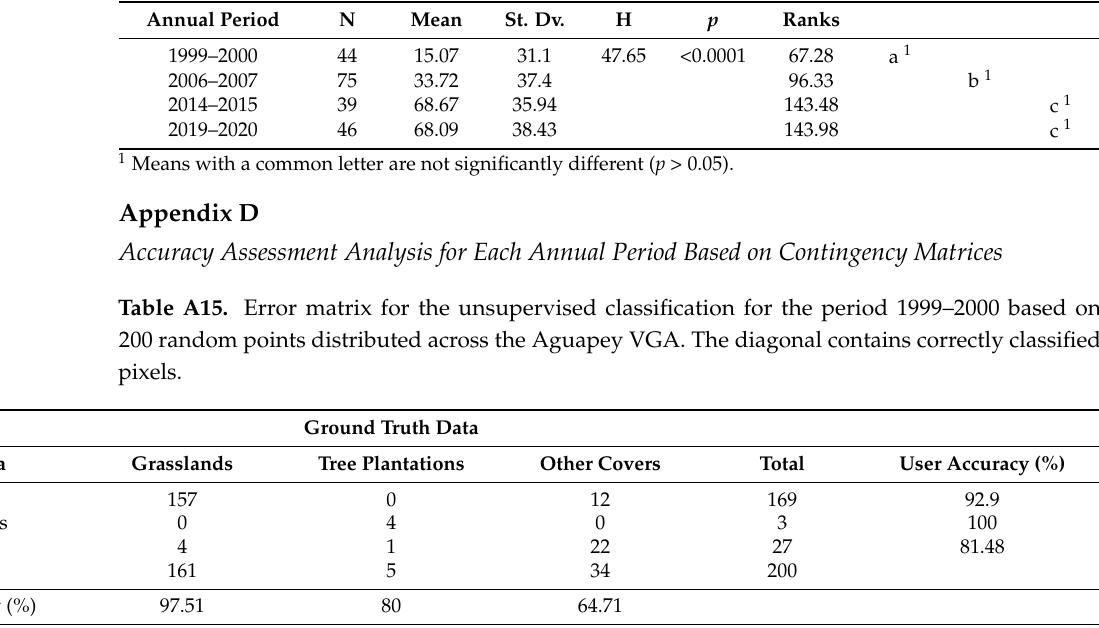
Table A14. Edge Contrast Index’s Kruskal Wallis tests between time periods for the Santo Tom é district. St. Dv. H p Ranks